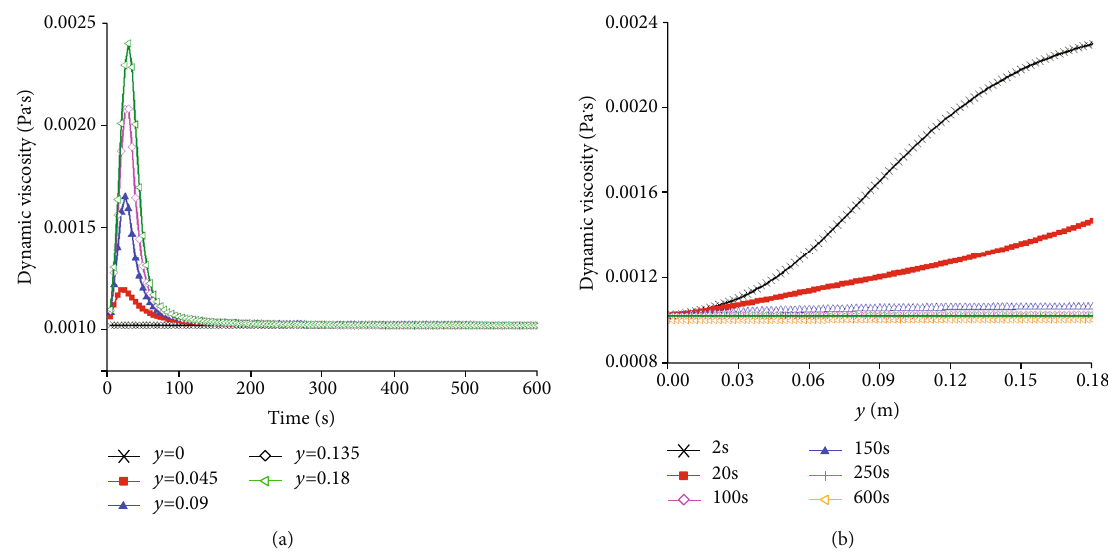
Figure 5: Evolution of fl uid dynamic viscosity: (a) over time and (b) with